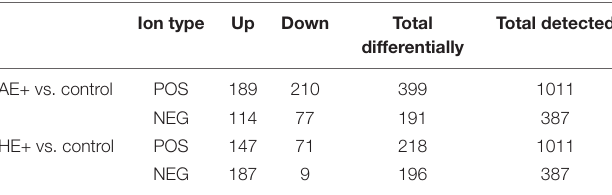
TABLE 2 | Metabolomic data based on a culture medium with the addition of auto- and heterotrophic Euglena , AE+ and HE+,